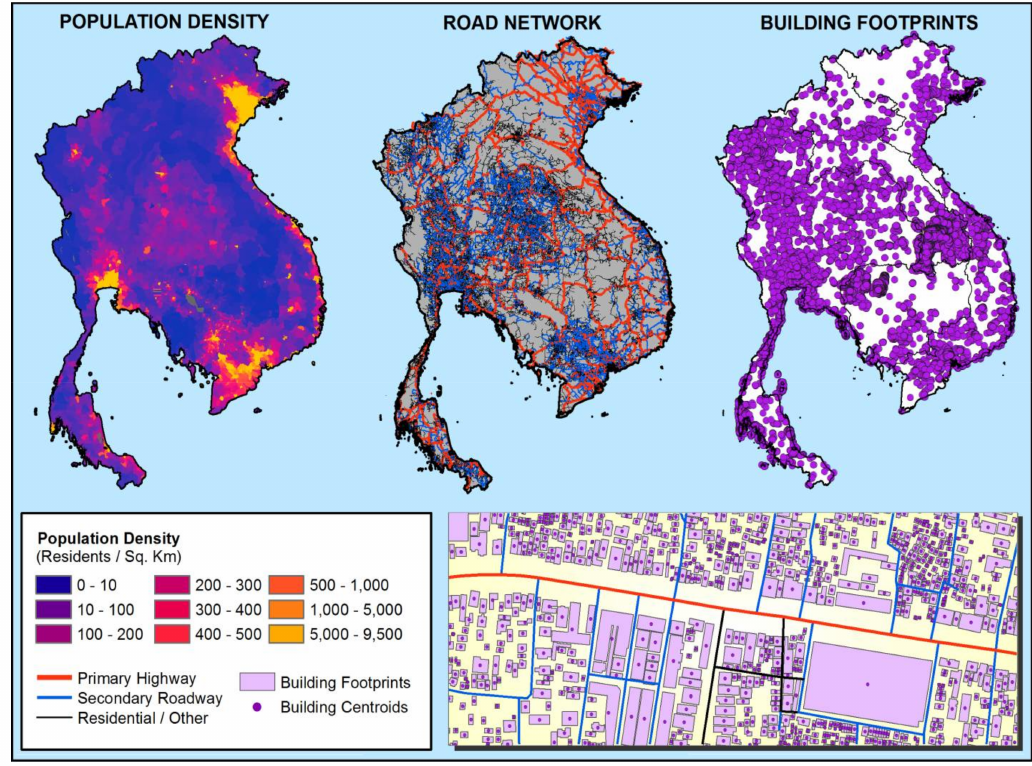
Figure 4. Population density ( left ), regional road networks ( center ), and building centroid and footprint data ( right, below ) considered in this